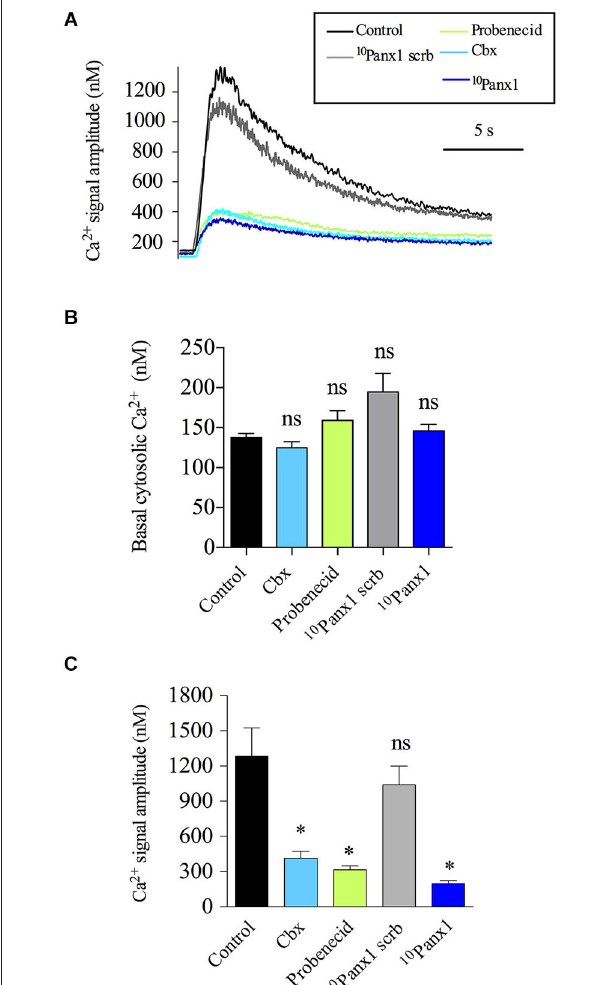
FIGURE 4 | Panx1 channels contribute to the Ca 2 + signal induced by the activation of nicotinic receptors . Indo-1 loaded chromaffin cells were stimulated with a 10 s pulse of the nicotinic agonist DMPP (50 µ M), and the cytosolic [Ca 2 + ] was monitored by microfluorometry. (A) Representative traces of [Ca 2 + ] rises induced by DMPP. Note that the evoked [Ca 2 + ] rise was reduced in the presence of Cbx (5 µ M), probenecid (200 µ M) or 10 Panx1 peptide (200 µ M). (B,C) Data show means ± SEM of basal cytosolic [Ca 2 + ] (B) or the maximum amplitude of the Ca 2 + signals induced by DMPP (C) in control cells ( n = 69), cells treated with probenecid ( n = 40), 10 Panx1 scrb peptide ( n = 37) or 10 Panx1 peptide ( n = 31). Cbx, probenecid and 10 Panx1 peptide treatment significantly reduced the amplitude of the DMPP-induced Ca 2 + signal. ns = non-significant, * p < 0.05 (Krukal-Wallis test) compare with control